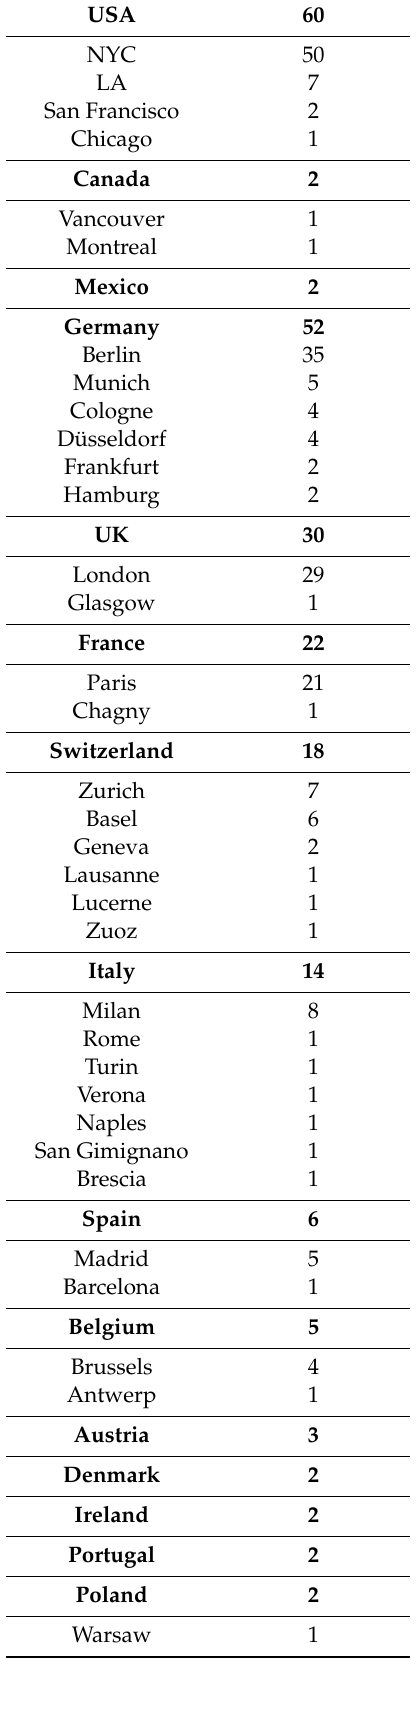
Table1. Mainlocationofthe247galleriesparticipatingtothe2019editionofArtBaselinthe“gallery”section.